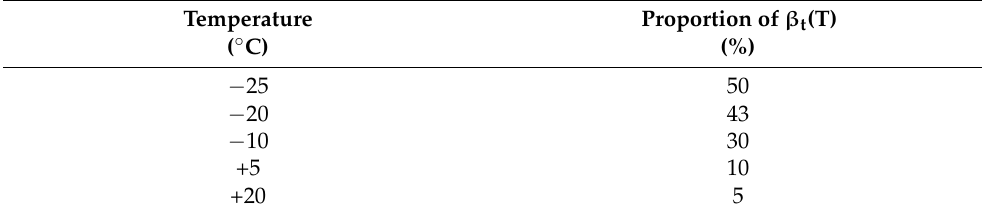
Table 2. Recommended test conditions for